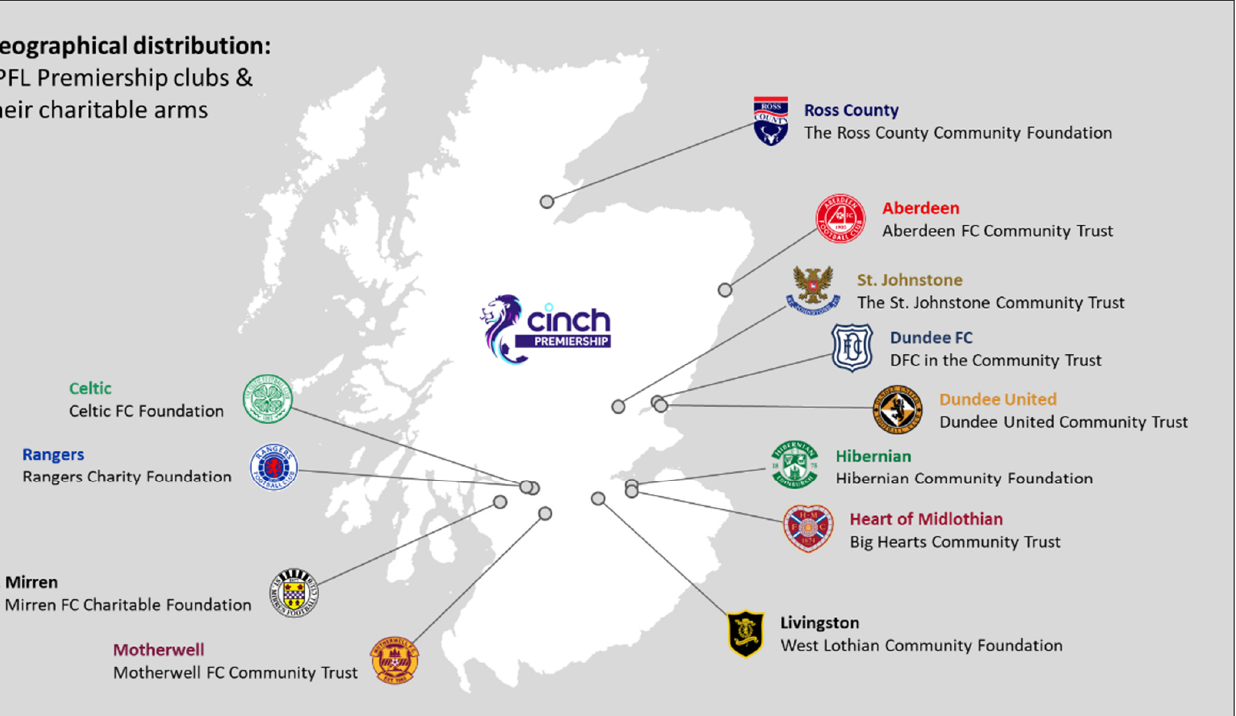
Figure 1. Revenue development in the Scottish Premiership (data from Deloitte 2016, 2017, 2018, 2019, 2020, 2021).